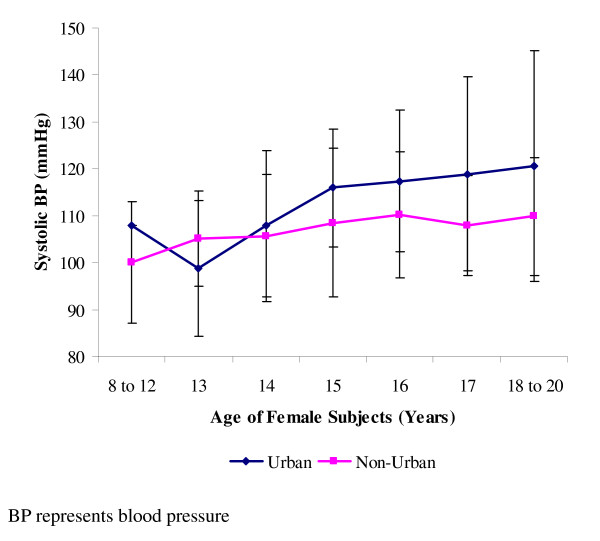
Mean systolic blood pressures of female subjects. Data (mean ± standard deviation) are for systolic blood pressures of 473 females studied, and made up of 217 urban dwellers and 256 non-urban dwellers.